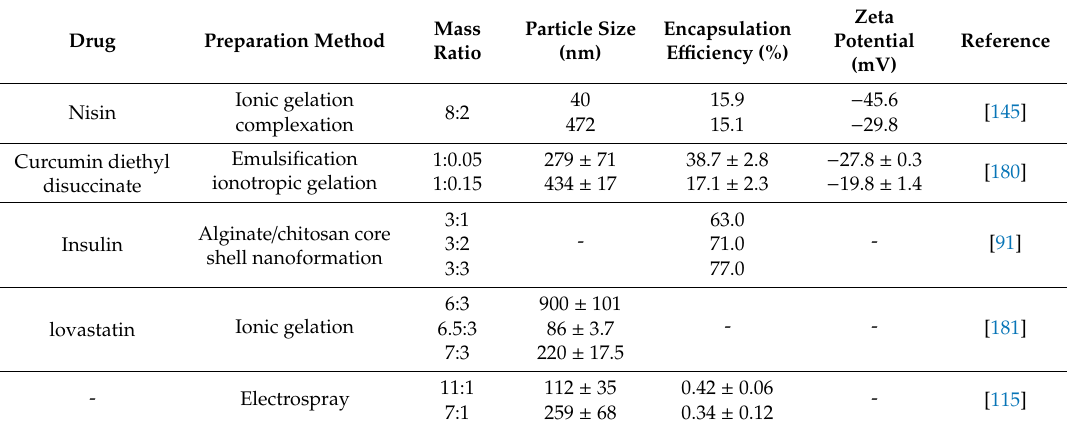
Table 7. Influence of alginate:chitosan ( w / w ) mass ratio on alginate